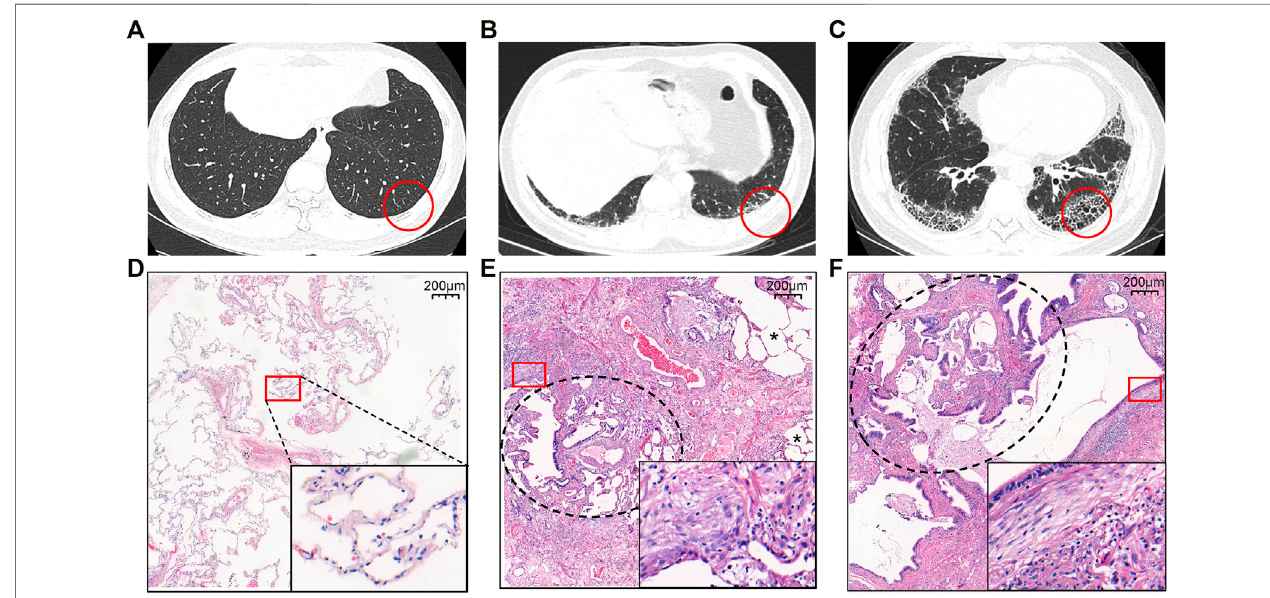
FIGURE1| RepresentativeHRCT (A – C) andhistology (D – F) fi ndingsinpatientswithIPF (B,C,E,F) andhealthycontrols (A,D) . (AandD) Thenormalappearance of HRCT and histopathology from HC. (B) The HRCT topographies in the IPF patients at early stage of SLB demonstrating subpleural, basal-predominant (often heterogeneous)subtlereticulation,mildgroundglassopacity(GGO),ordistortion(indeterminateforUIP). (C) TheHRCTtopographiesintheIPFpatientsatthetransplant stage from lung transplantation demonstrating a typical UIP with characteristics of subpleural, basal-predominant (heterogeneous) honeycombing, and bronchiolectasis. (E and F) Histopathology patterns of UIP, characterized by dense fi brosis with a predilection for subpleural and paraseptal parenchyma with associated architectural distortion in the form of microscopic honeycomb change black circle pointed juxtaposed with relatively unaffected lung parenchyma (*) and fi broblastfoci(squarecircle).Among them,EcomesfromtheIPFlungtissueofSLB, withmorerelatively unaffected lungparenchyma (*),whileFisfromtransplantedIPF lungtissue,withhoneycombchange(blackcircle).TheredcircleistheareaofthebiopsyshowninHRCT,whilethesquarecircleisusedformagni fi cationtopresentvery dense fi brosis (collagen fi bers and fi broblasts). Abbreviation: SLB, surgical lung biopsy.